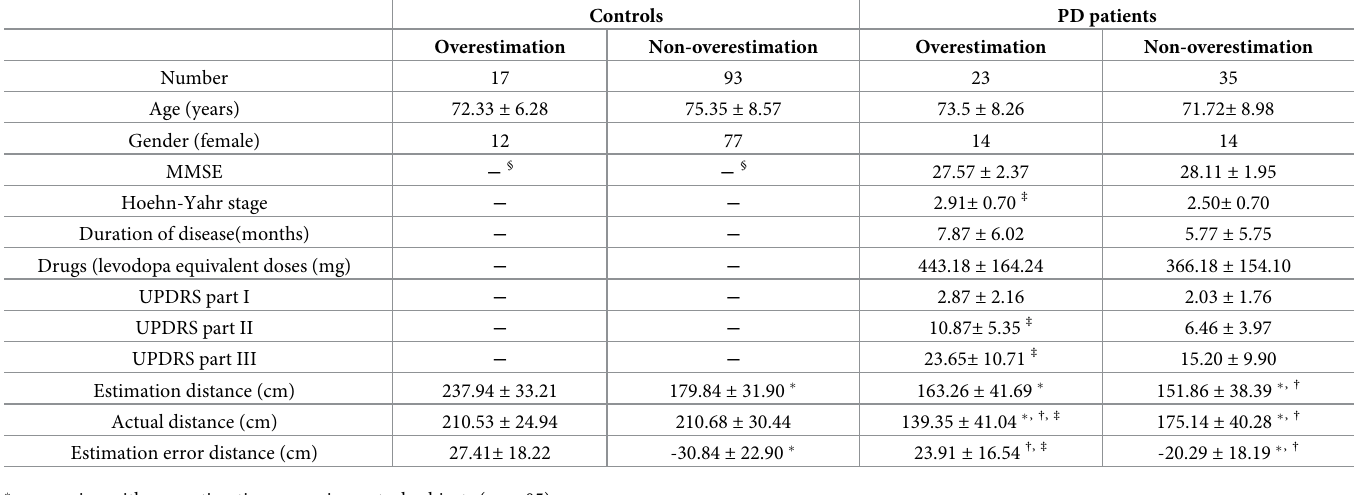
Table 1. Demographic clinical details and results of two-step test of control groups (non-overestimation and overestimation) and patients with PD groups (non- overestimation and overestimation) (mean ± SD